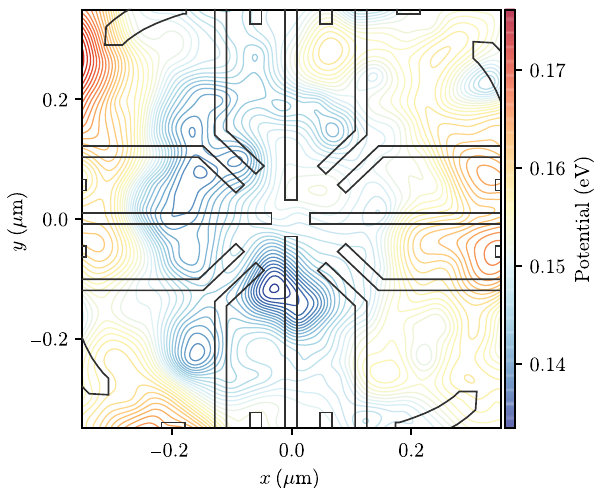
FIG. 12. Simulation of the electrostatic potential arising from a random distribution of donors. The potential is computed for a random distribution of donors in the Si-doped layer of the heterostructure that produces a 2DEG with an electron density of 2.7 × 10 11 cm 2 . The induced potential can localize the dots in different spatial positions than the one intended by the gate